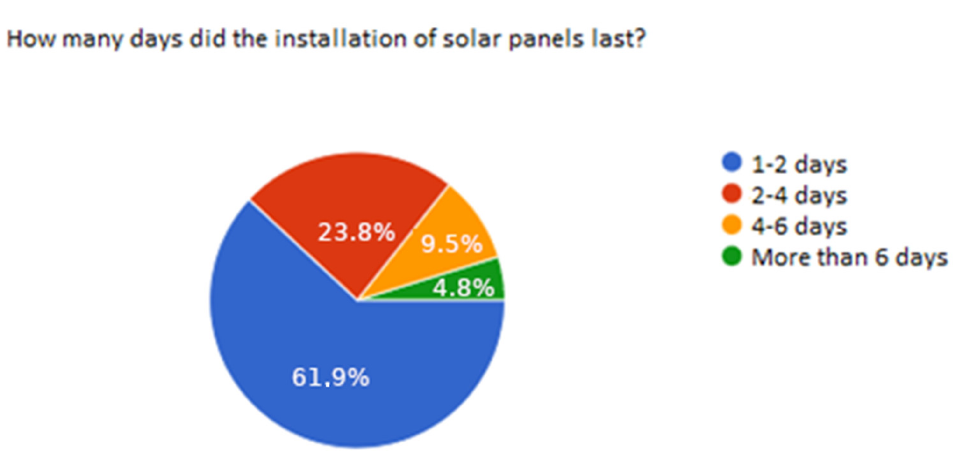
Figure 6. Duration of the installation assembly.